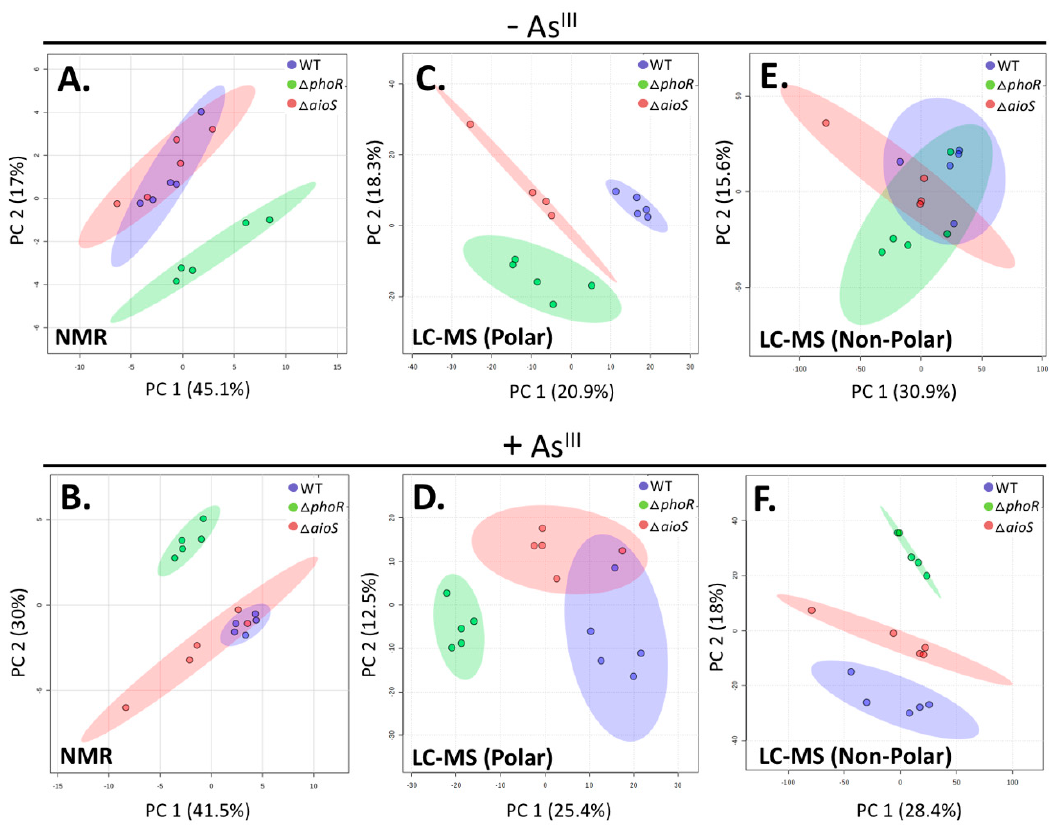
Figure 1. 2D Principal Component Analysis (i.e., 2D-PCA scores plots) of metabolite profiles from 1 H nuclear magnetic resonance (NMR) and untargeted liquid chromatography-mass spectrometry (LC-MS) metabolomics data. Metabolites from cultures grown without As III : ( A ) NMR, ( C ) polar LC-MS, and ( E ) non-polar LC-MS metabolites. Metabolites from cultures grown in the presence of As III : ( B ) NMR, ( D ) polar LC-MS, and ( F ) non-polar LC-MS. Wild-type (WT) = purple; ∆ phoR = green; ∆ aioS = red. Shaded ellipses denote 95% confidence intervals.